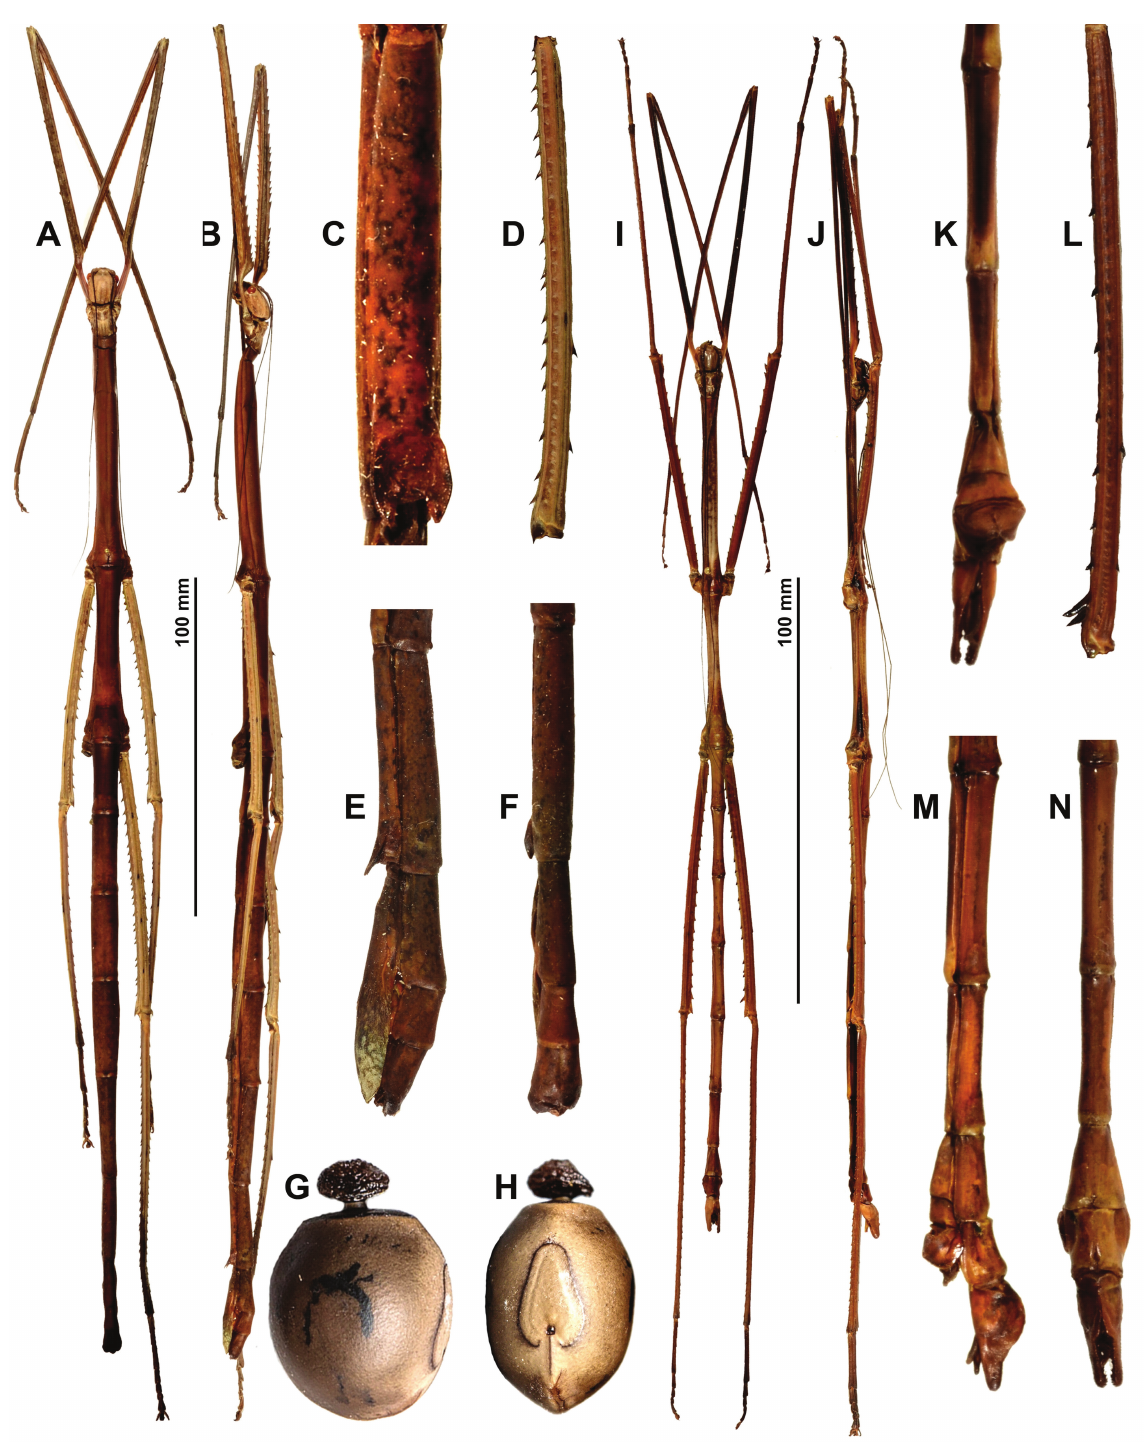
Fig. 8. Phryganistria heusii yentuensis subsp. nov . — A–F . ♀. A . Habitus, dorsal view. B . Habitus, lateral view. C . Sternum VII and praeopercular organ. D . Mesofemur, lateral view. E . Apex of abdomen, lateral view. F . Apex of abdomen, dorsal view. — G–H . Egg. G . Lateral view. H . Dorsal view. — I–N . ♂. I . Habitus, dorsal view. J . Habitus, lateral view. K . Apex of abdomen, ventral view. L . Mesofemur, lateral view. M . Apex of abdomen, lateral view. N . Apex of abdomen, dorsal view. C–H, K–N = not to